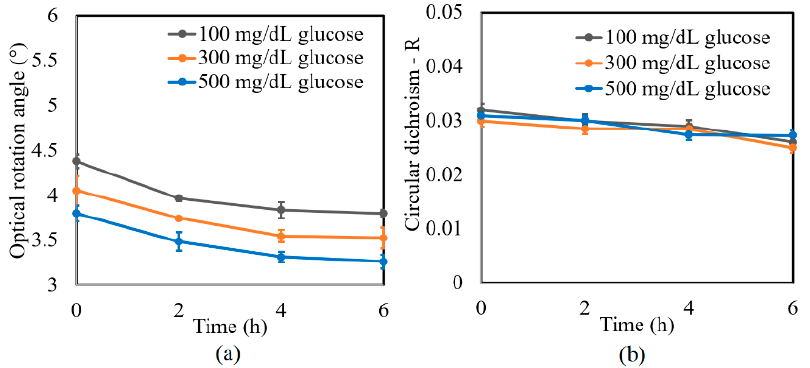
Figure 6. Experimental results for variation in: ( a ) γ and ( b ) R of glucose tissue phantom solutions mixed with 3000 mg/dL of albumin over time interval of 6 h.